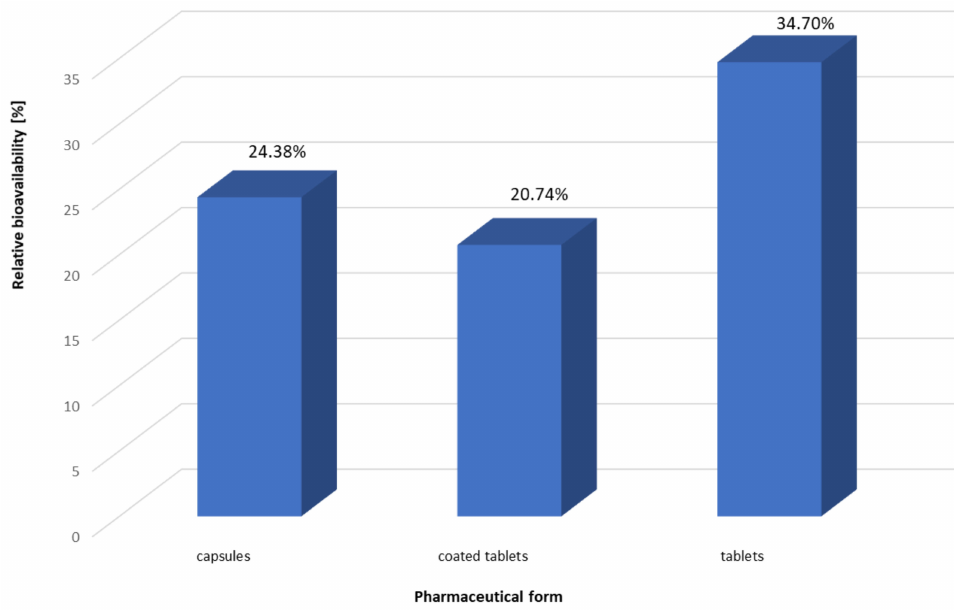
Figure 2. Bioavailability of Se considering the pharmaceutical form of the dietary